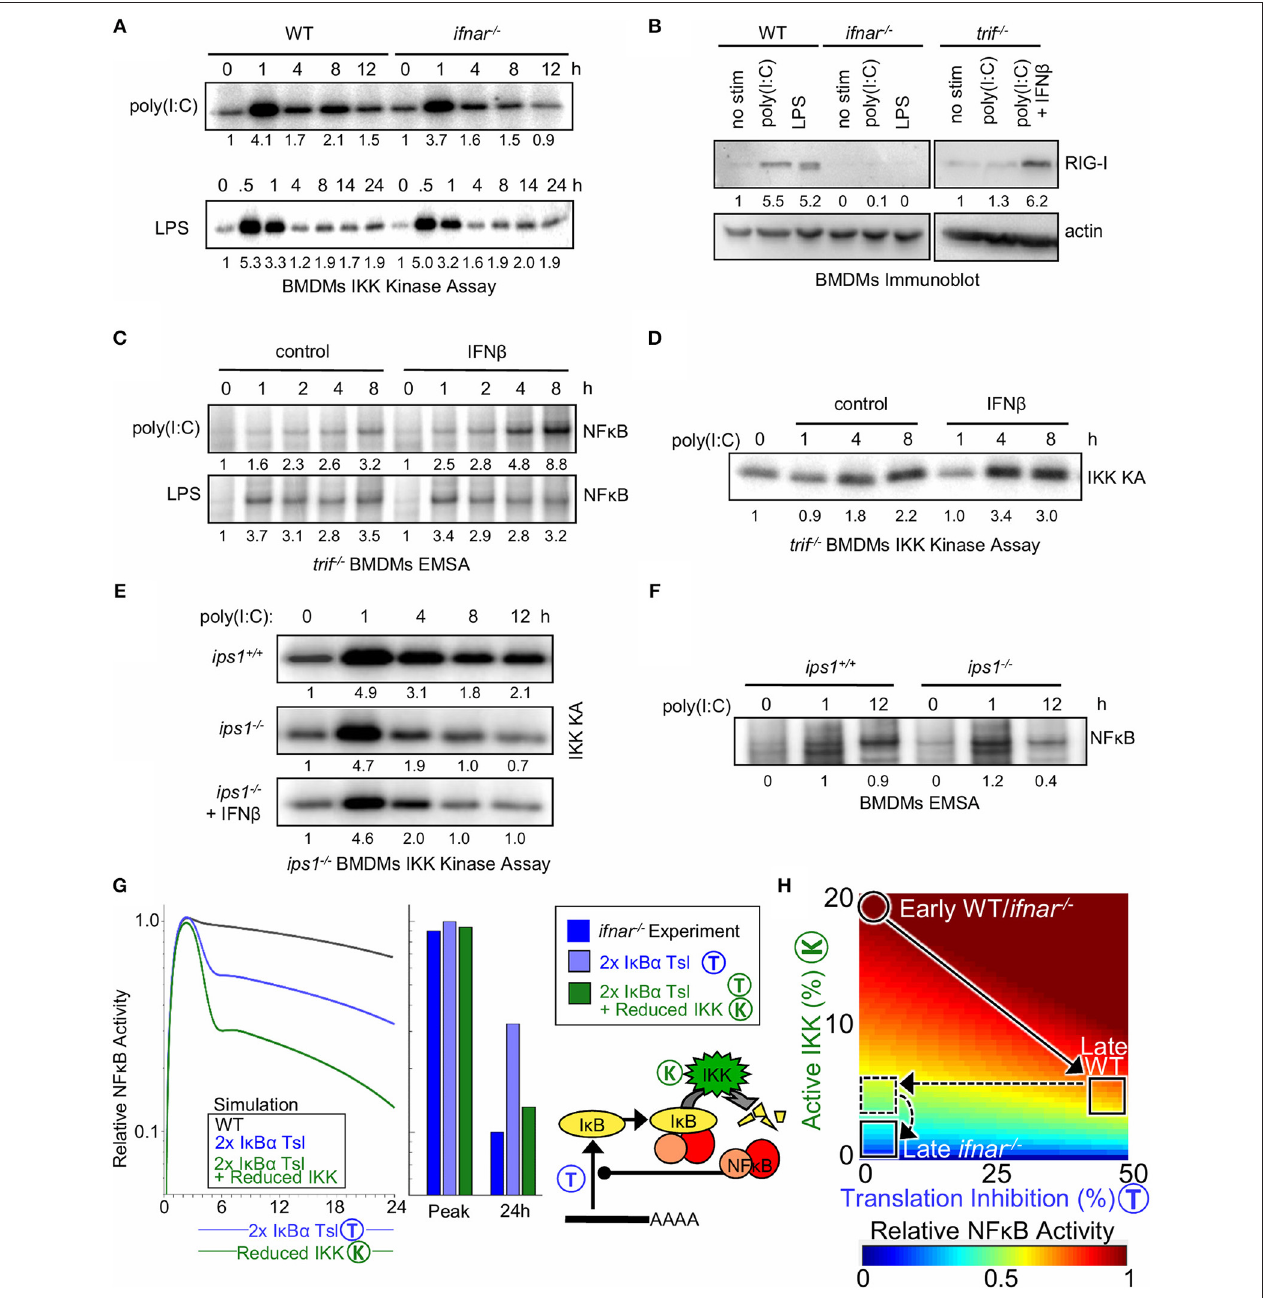
FIGURE 4 | Type I interferon potentiates late NF κ B activation by poly(I:C) by decreasing I κ B translation and increasing bound I κ B degradation via elevated RigI expression. (A) Immunoprecipitation kinase assay (kinase A) of IKK activity in WT and ifnar − / − BMDMs in response to poly(I:C) and LPS. (B) Immunoblot of RIG-I expression after 8h of poly(I:C) or LPS treatment in WT, ifnar − / − and trif − / − BMDMs; and rescue of trif − / − cells with IFN β . (C) EMSAs of NF κ B activation by poly(I:C) and LPS in trif − / − BMDMs with and without IFN β co-treatment. (D) IKK activity in WT and ips − / − BMDMs exposed to poly(I:C) and in ips − / − cells with co-treatment with IFN β . (E) IKK activity in trif − / − BMDMs with and without IFN β co-treatment. (F) EMSAs of NF κ B activation by poly(I:C) in ips1 + / + and ips1 − / − BMDMs. (A–D) show a dataset representative of at least three biological replicates, and (E,F) show a representative of two biological replicates (we gratefully acknowledge Zhijian James Chen for ips1 − / − bone marrow). Quantitations are relative to basal or peak activity, which is set to 1. (G) (Left) Simulated NF κ B timecourse in response to IKK activation representative of poly(I:C) stimulation, with a 2-fold increase in I κ B α translation (blue) or with both I κ B α translation inhibition and 50% IKK activity reduction as seen in ifnar − / − (green). (Right) Bar graph of NF κ B activity at the peak and 24h time point as quantified from simulations and experiments ( Figure 2A ). (H) Heatmap of NF κ B activity calculated using SiMoN for 50 increasing IKK activity values and 50 increasing degrees of translation inhibition (2,500 total points). In both WT and ifnar − / − poly(I:C) stimulation results in increased IKK activity during the early phase. Following this WT cells undergo 50% translation inhibition and IKK activity decreases. ifnar − / − cells lack translation inhibition (horizontal dashed line, Figure 3 ), and have decreased late-phase IKK activity [vertical dashed line, this (A–F) ].